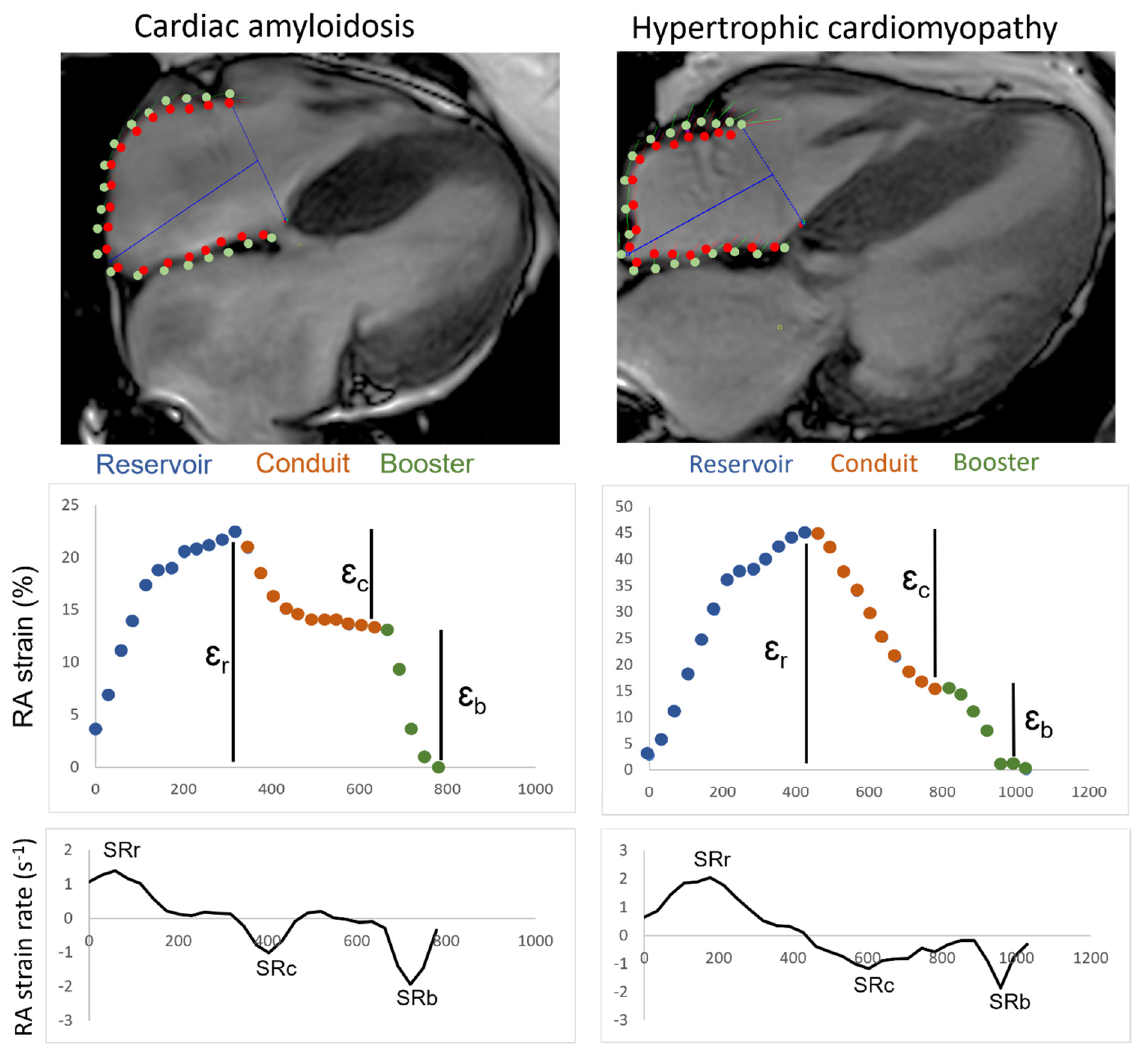
Figure 1. CMR Strain Analysis of CA and HCM. Contouring of the endocardial and epicardial right atrium in four-chamber view of a CA and HCM patient, along with corresponding strain and strain rate curves. RA—right atrial; ε r —reservoir strain; ε c —conduit strain; ε b —booster strain; SRr—reservoir strain rate; SRc—conduit strain rate; SRb—booster strain